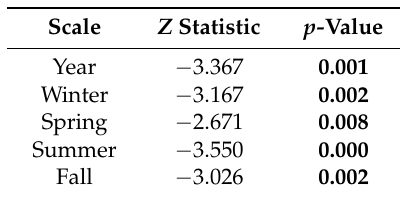
Table 2. Analysis of the long ‐ term trend of annual and seasonal minimum daily flows using the Mann ‐ Kendall method.